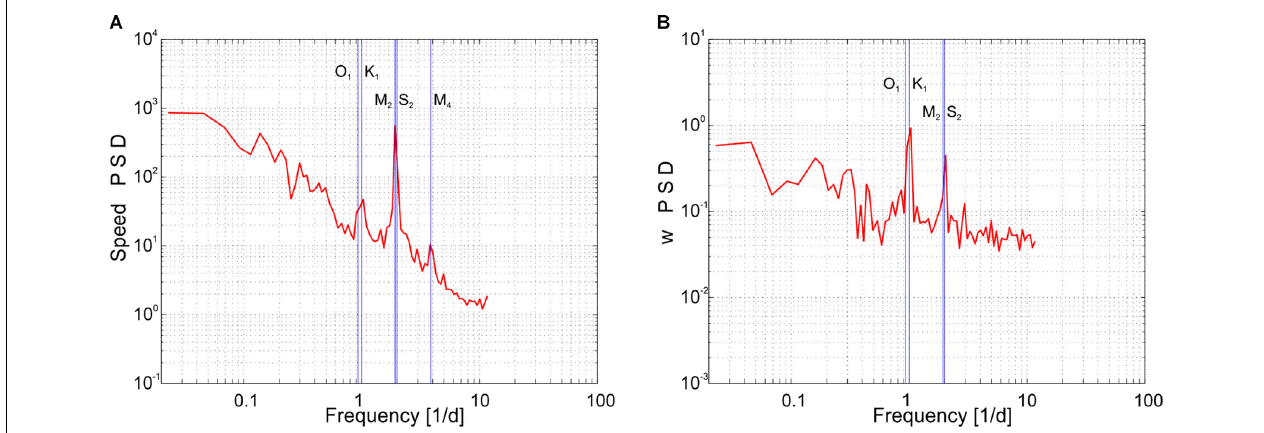
FIGURE 5 | Power Spectral Densities computed using horizontal current speeds (A) and vertical velocities (B) obtained by the moored ADCP averaged vertically between 100 and 200 m. Labels were given to single peaks at tidal constituent frequencies (O1, K1, M2, S2, and M4).